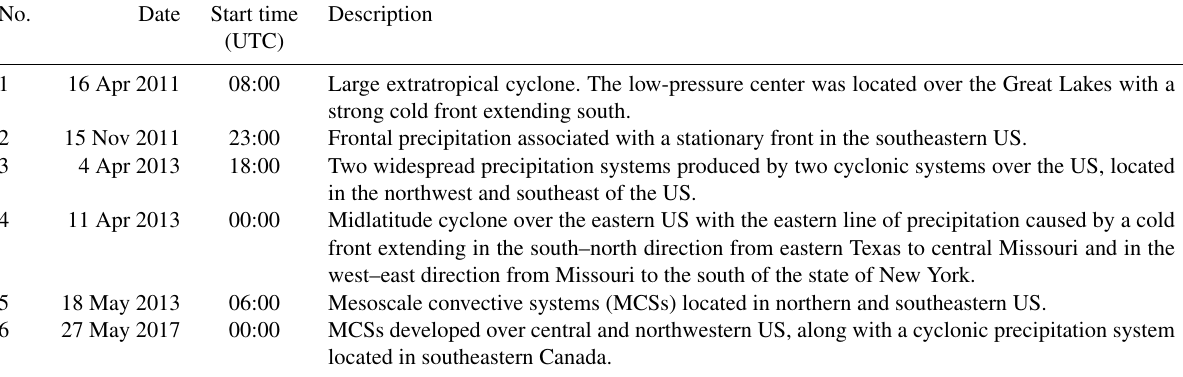
Table 9. Precipitation events from the US. The duration of each event is 12h. No.